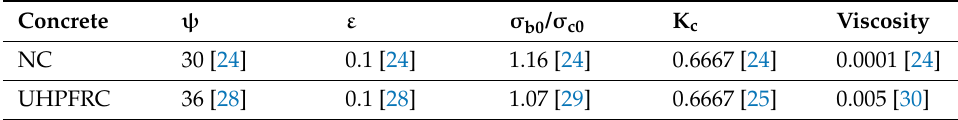
Figure 6. Response of concrete to a uniaxial loading condition: ( a ) compression and ( b ) tension [23]. Table 3. Parameters of the CDP model for NSC and UHPFRC materials .